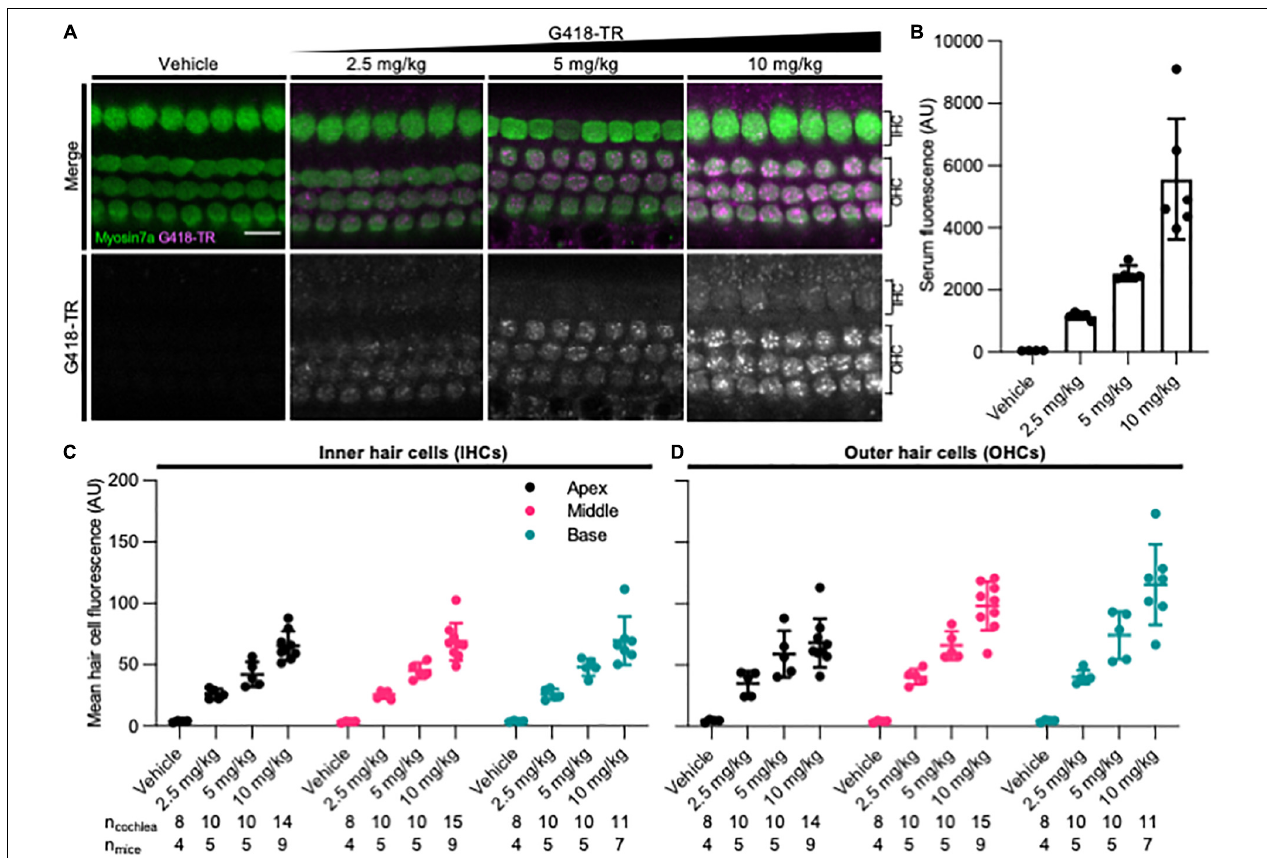
FIGURE 1 | G418-TR is taken up by neonatal mammalian hair cells following systemic administration. (A) At 6 h after systemic injection with G418-TR, neonatal mice (P5) were sacrificed, cochlear sensory epithelia was dissected and fixed, and tissue was immunolabeled for myosin VIIa. Representative single z-plane images captured from the middle turn of the cochlea in the region between the cuticular plate and nucleus demonstrate dose-dependent uptake of G418-TR in OHCs. Scale bar = 10 µ m. (B) 6 h after systemic administration of G418-TR, blood was collected from neonatal mice, serum was extracted, and fluorescence was quantified with a fluorescence plate reader. Increasing doses of G418-TR results in a dose-dependent increase in serum fluorescence [One-way ANOVA; F ( 3 , 16 ) = 25.02, P < 0.0001]. (C) Mean G418-TR fluorescence intensity of IHCs by tonotopic region 6 h after systemic treatment. IHCs demonstrate similar dose-dependent uptake of G418-TR in base, middle, and apex. (D) Mean G418-TR fluorescence intensity of OHCs by tonotopic region 6 h after systemic treatment. OHCs demonstrate significant dose-dependent and tonotopic G418-TR uptake [Mixed effects analysis; F ( 6 , 36 ) = 5.127, P = 0.0007]. n cochlea and n mice represent the number of cochlea and mice examined, respectively. When two cochlea from the same animal were analyzed, the animal mean was calculated and used for all statistics and graphs. Error bars are standard deviations. AU, arbitrary unit.